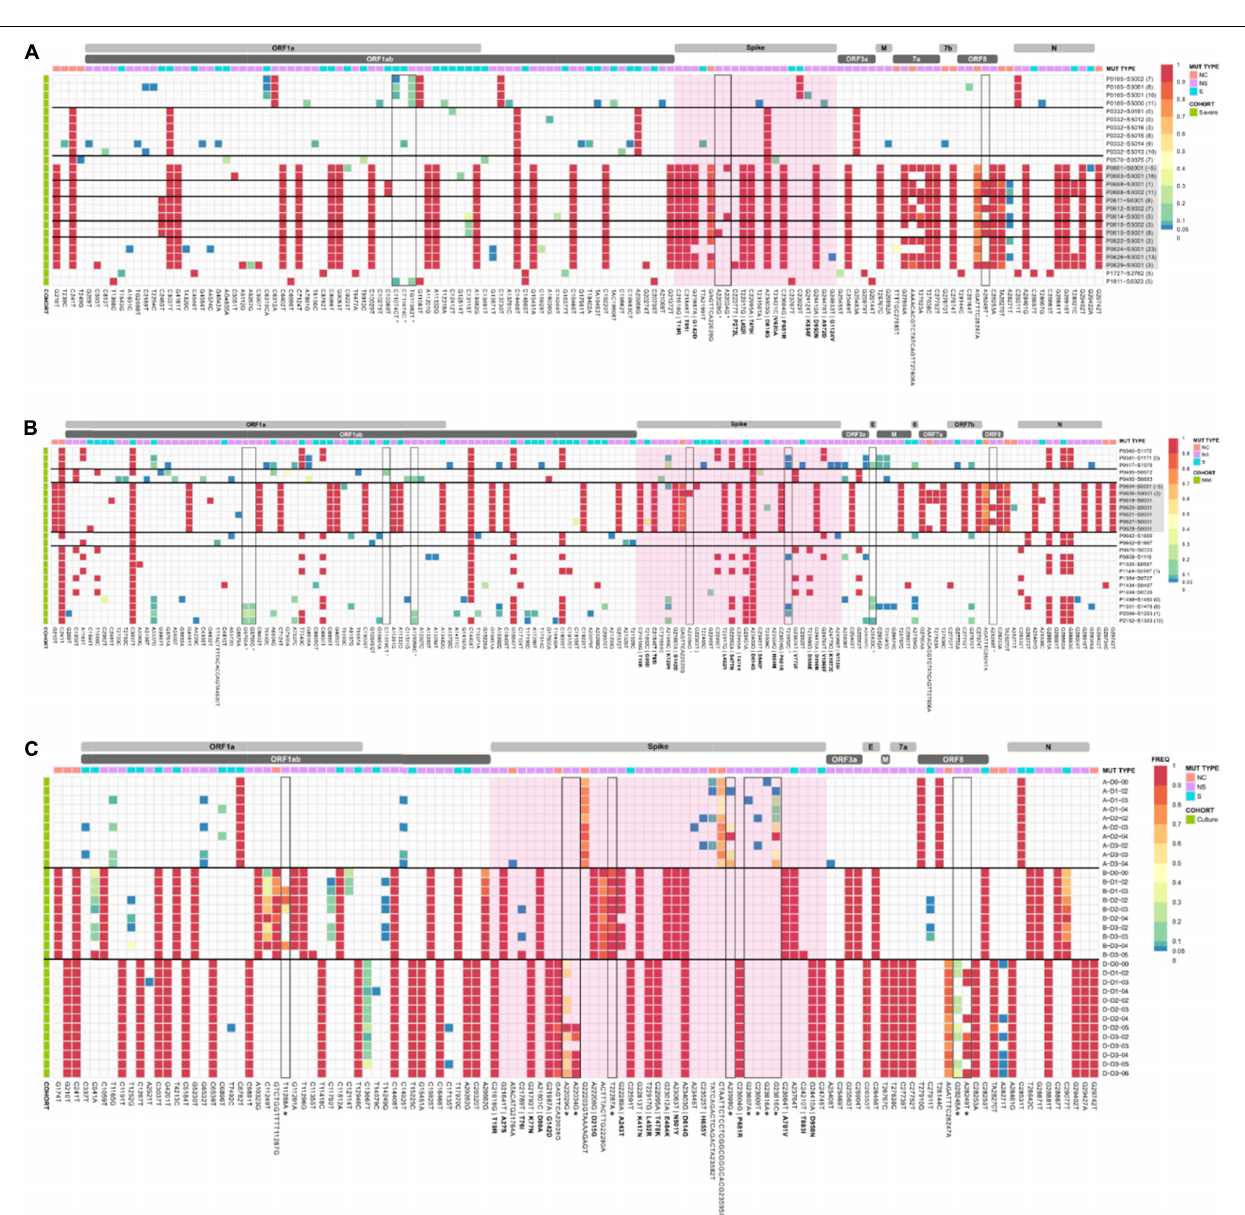
FIGURE 2 | iSNV and SNP frequencies and the corresponding synonymous and non-synonymous mutations across the SAR-CoV-2 genomes for the (A) severe and (B) mild cohorts, and (C) culture dilutions. A frequency of ≥ 0.9 was considered a SNP (red), frequencies below 0.05 were not included in the analysis. Identified problematic sites are outlined in black and denoted with an * on the x -axis. Amino acid changes for non-synonymous mutations in the spike region are in bold. The spike gene is highlighted in pink. SARS-CoV-2 Delta lineages are highlighted in grey. Horizontal black bars group samples from the same patient. Descriptors A, B, and D in panel (C) refer to Lineage A, B.1.351, and B.1.617.2, respectively. Bracketed numbers indicate the date of sample collection post-symptom